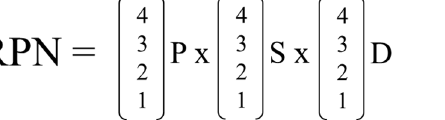
Figure 1. The calculation method of a risk priority numbers (RPN) Table 1. Main risk assessment of the critical material attributes (A) and critical process parameters (B) affecting critical quality attributes. (A)